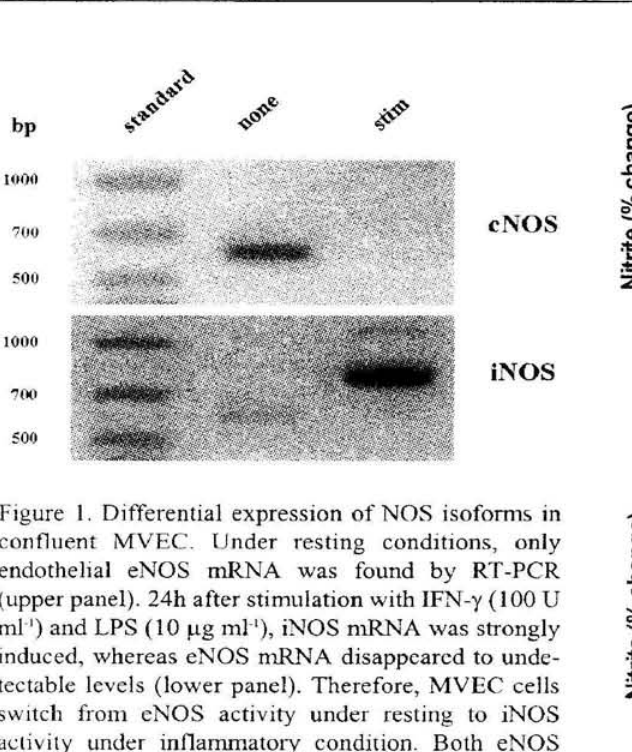
Figure I. Differential expression of NOS isoforms in confluent MVEC. Under resting conditions, only endothelial eNOS mRNA was found by RT-PCR (upper panel). 24h after stimulation with IFN-γ (100 U ml·') and LPS (10 μg ml· 1 ), iNOS mRNA was strongly induced, whereas eNOS mRNA disappeared to unde- tectable levels (lower panel). Therefore, MVEC cells switch from eNOS activity under resting to iNOS activity under inflammatory condition. Both eNOS and iNOS were determined in the same cDNA prepa- rations.